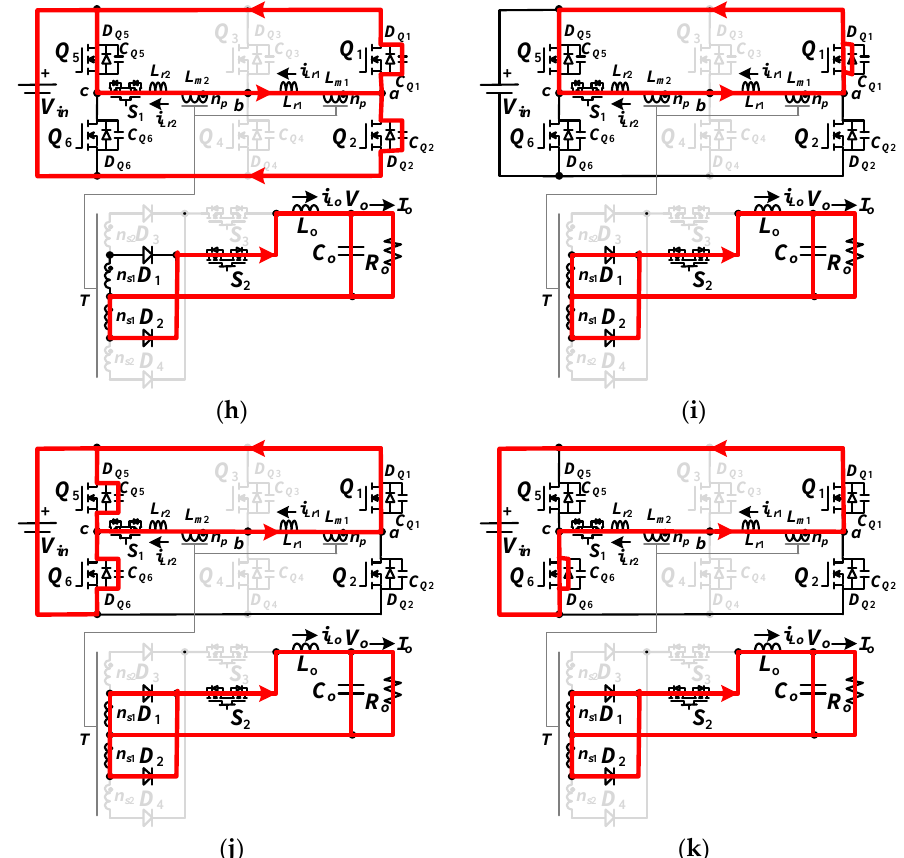
Figure 5. PWM waveforms and equivalent circuits at high voltage range operation: ( a ) PWM voltage and current waveforms for ( b ) Mode 1, ( c ) Mode 2, ( d ) Mode 3, ( e ) Mode 4, ( f ) Mode 5, ( g ) Mode 6, ( h ) Mode 7, ( i ) Mode 8, ( j ) Mode 9, and ( k ) Mode 10.